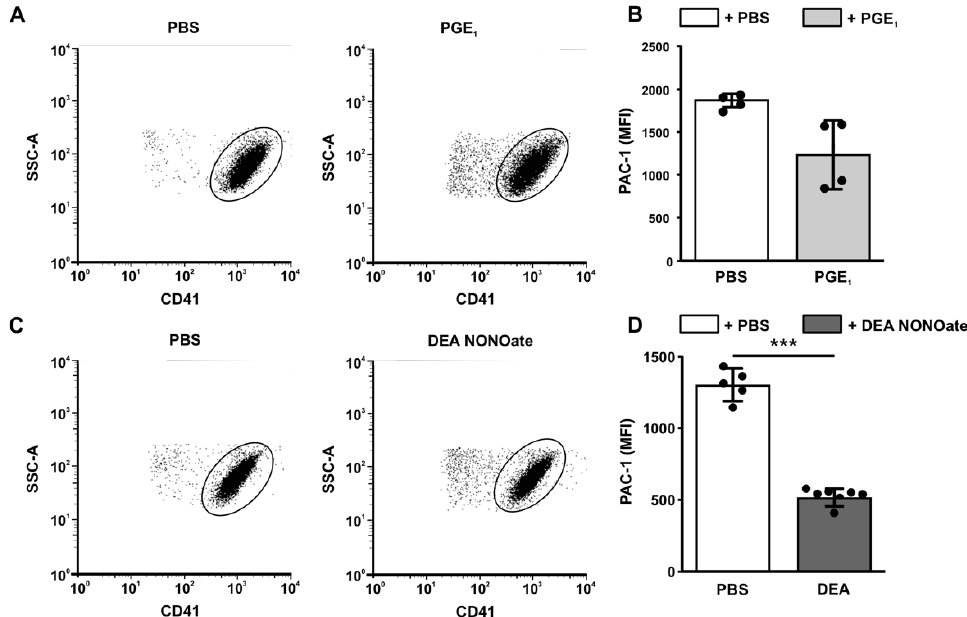
Figure A4. Gating strategies and MFI for cytometry analysis shown in Figure 3. Human platelets were treated with ( A , B ) either PGE 1 or ( C , D ) DEA NONOate. ( A , C ) Human platelets were gated according to SSC and CD41. ( B , D ) Activation status of GPIIb/IIIa (PAC-1) is presented as mean fluorescence intensity (MFI). n ≥ 4; unpaired Student’s t -test with *** for p < 0.001.